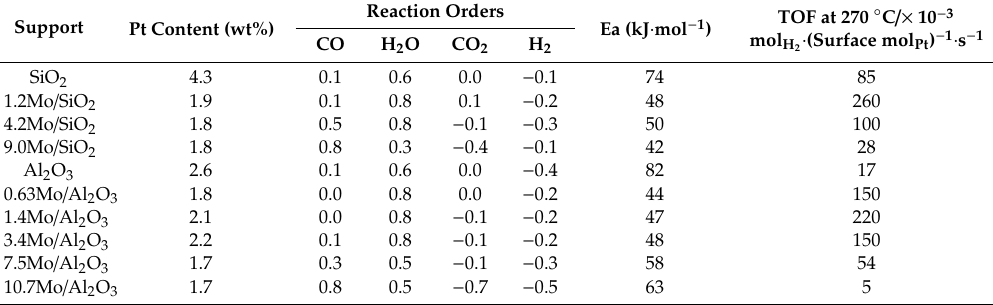
Table 6. Results of kinetic measurements over doped and un-doped Pt / SiO 2 and Pt / Al 2 O 3